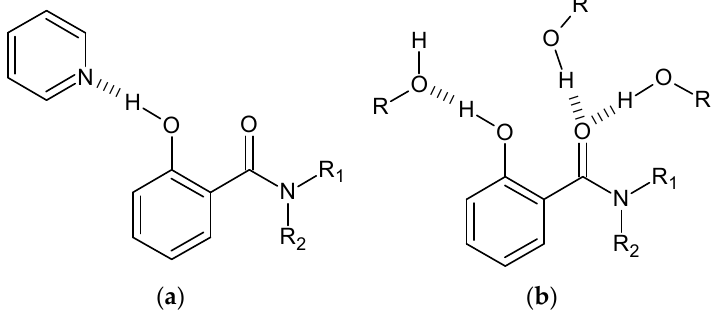
Figure 16. Complexes of 2-hydroxy- N , N -diethylbenzamide ( 3 , R 1 = R 2 = C 2 H 5 ; Figure 1) with pyridine ( a ) and alcohol ( b ) (R = alkyl group). Reprinted with permission from [94]. Copyright 2008 John Wiley & Sons, Ltd.